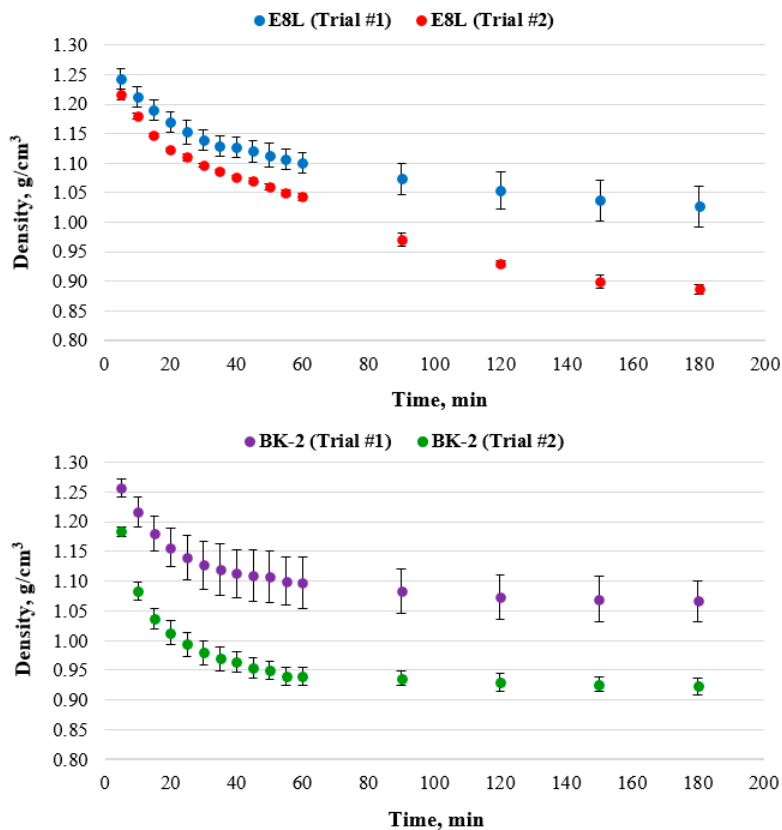
Figure 10. Graphs of changes in the density of explosives in time: E8L ( top ) and BK-2 ( bottom ). The analysis results indicate that the blending of components using a double static mixer (#2) is much more precise than blending with a single mixer (#1). This is shown by different density values of specific samples in trial #1. In turn, the differences between densities measured in trial #2 are much closer to each other. Smaller dispersion is also observed. This indicates that thorough blending is critical for maintaining higher detonation parameters, since the sensitizer is more evenly distributed throughout the entire mass of the matrix—greater reaction surface, and thus, greater gas volume and lower density. Thus, a double static mixer is highly recommended for further blasting opera- tions.